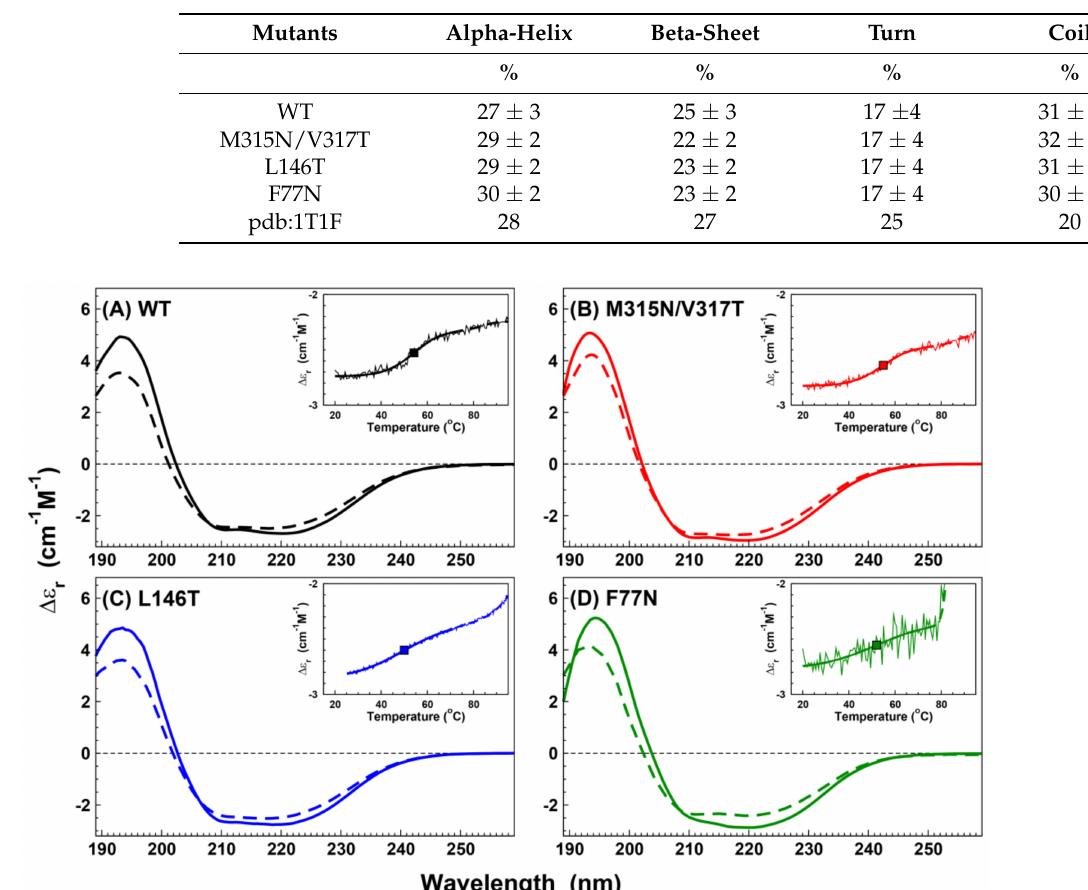
Table 2. Secondary structural elements of mutant antithrombin. The percentage of residues involved in the different secondary structure classes for the beta-wild type (WT) and variant antithrombins M315N/V317T, L146T, and F77N. The results calculated for the WT PDB structure 1T1F are reported for comparison. (Here, unresolved residues in PDB are considered as coil elements).